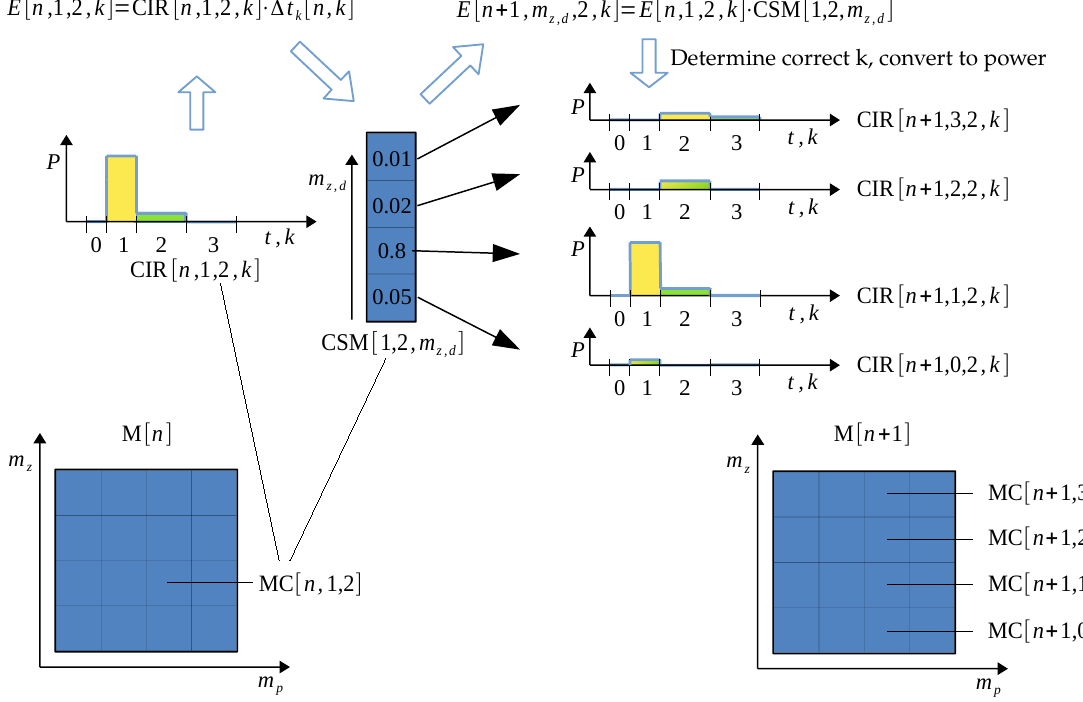
Figure 7. Transition of a cell impulse response to the next